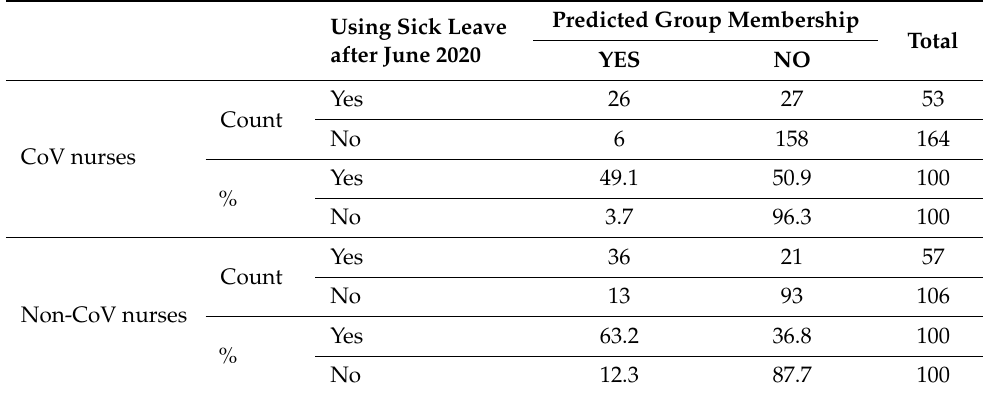
Table 5. Number and percentage of correct identification of nurses who used sick leave. Using Sick